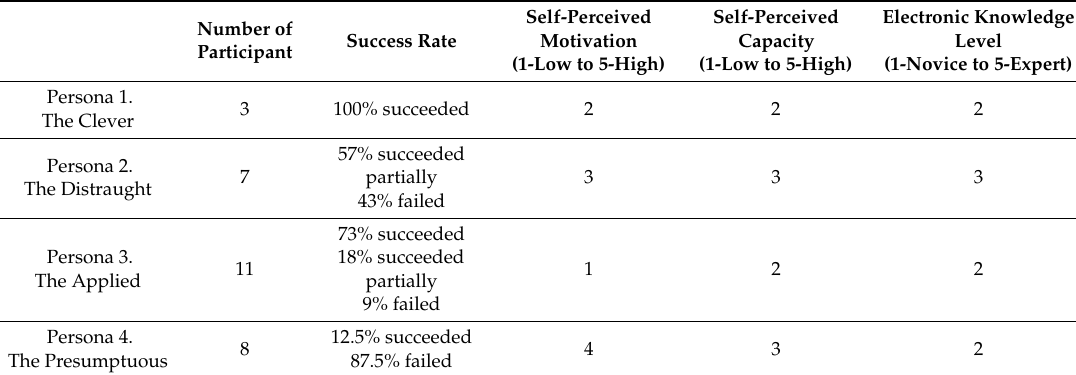
Table 4. Presentation of the 4 personas.